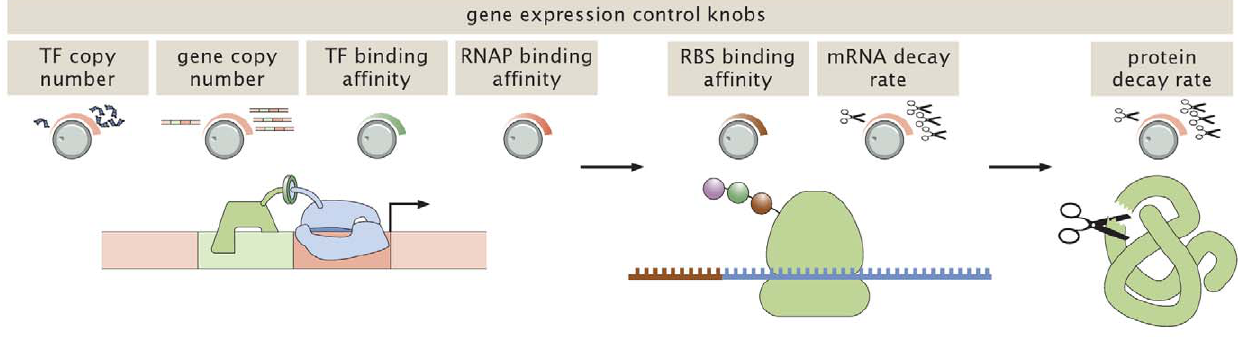
Figure 1. Regulatory control knobs. A schematic view of the available knobs which can be systematically tuned to change the mRNA and protein distributions. In this work we begin by studying constitutive expression, eliminating the extra layer of complexity associated with transcription factors, and systematically control the RNAP binding affinity through control of the promoter sequence. These results are then generalized to the case in which these same promoters are subjected to regulation by repressor binding, with the level of repressor (i.e. TF copy number) controlled systematically.